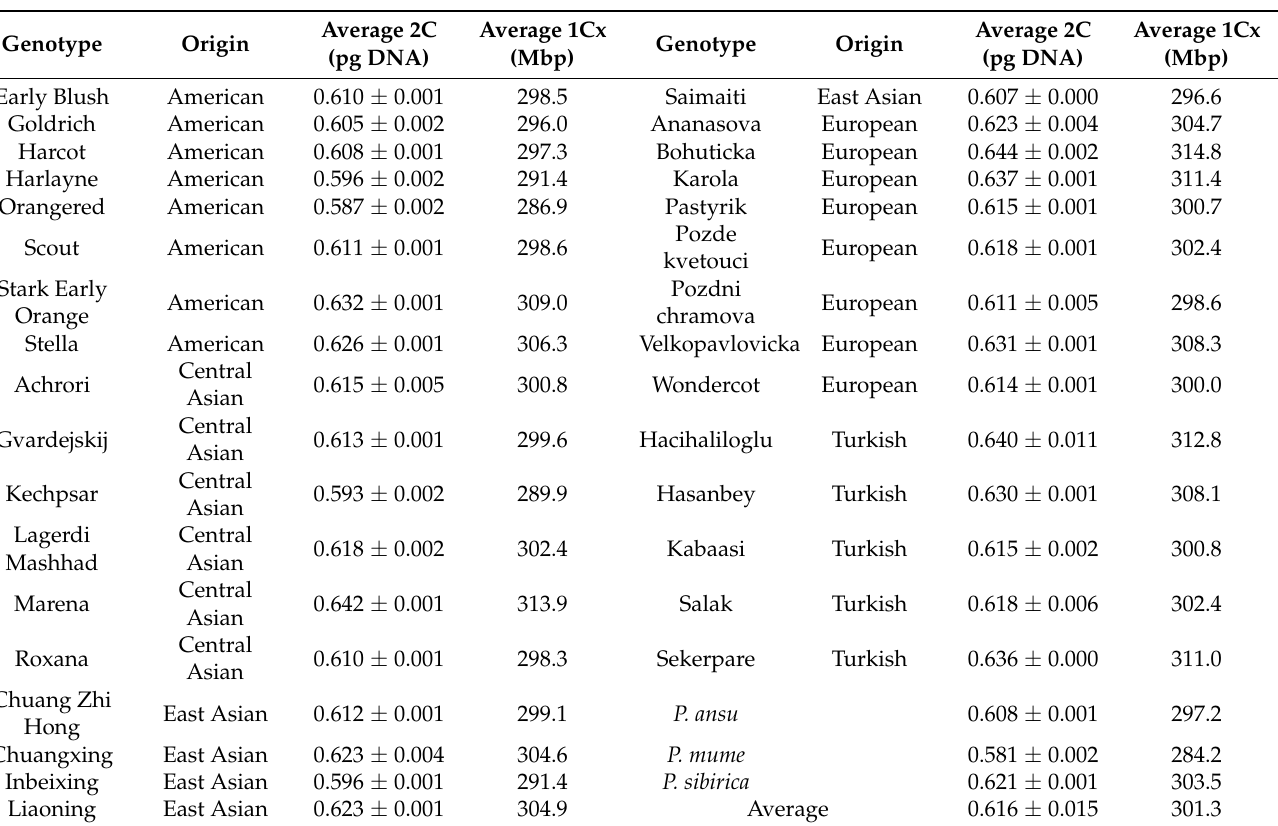
Table 3. The nuclear DNA content and monoploid genome sizes of the selected cultivars with different geographical